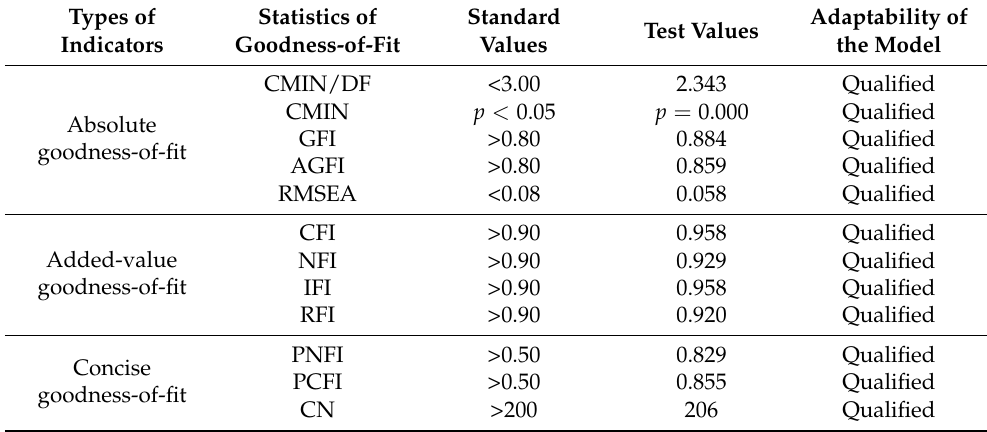
Table 3. Fit indices of the models.